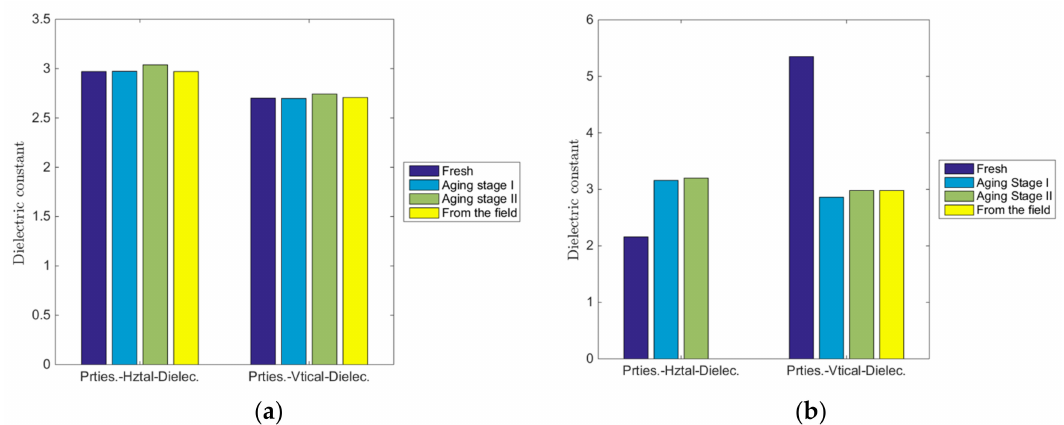
Figure 2. Measured dielectric constant of ( a ) mineral oil and ( b ) PAG oil during the stepped profile described in Section